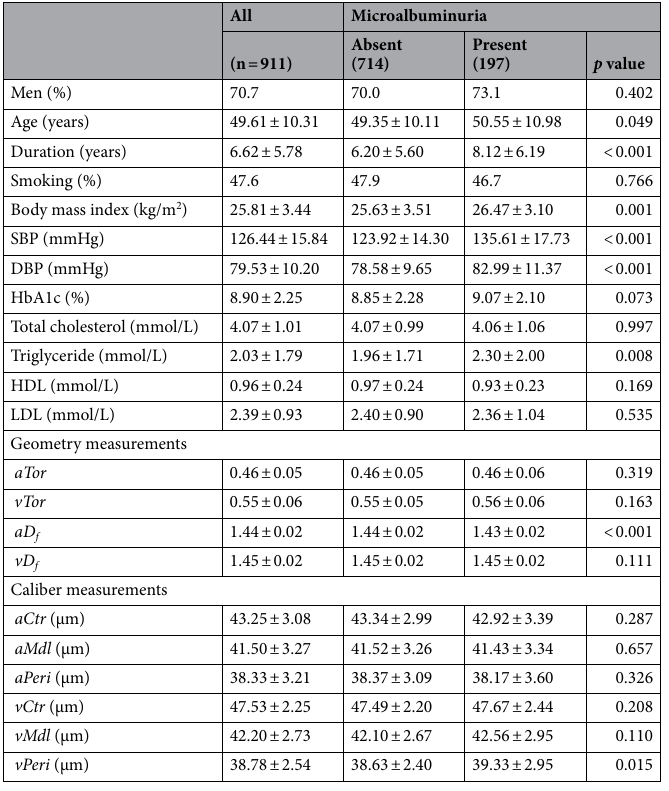
Table 1. Demographic and clinical baseline characteristics of the study subjects. Continuous variables are given as mean ± SD. MBI, body mass index; DBP, diastolic blood pressure; SBP, systolic blood pressure.